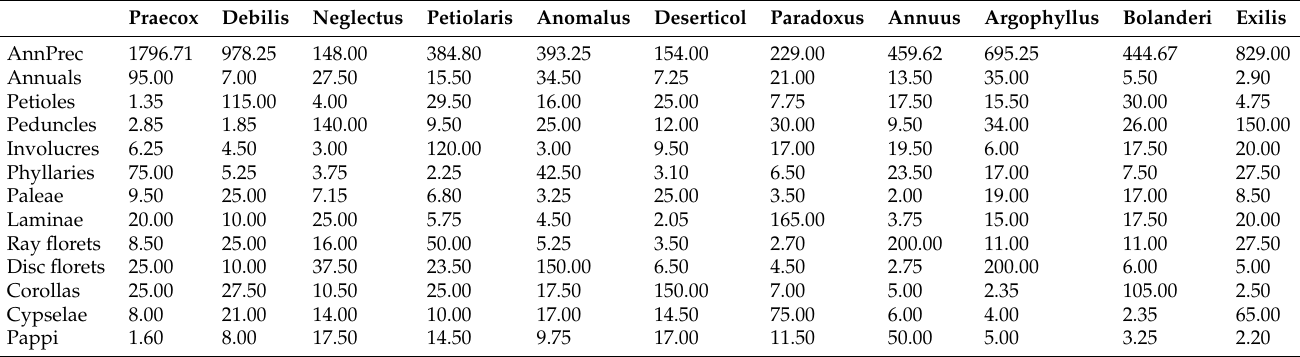
Table 2. Sunflowers and their traits. Each column represents a sunflower species, while each row records the trait collected from the